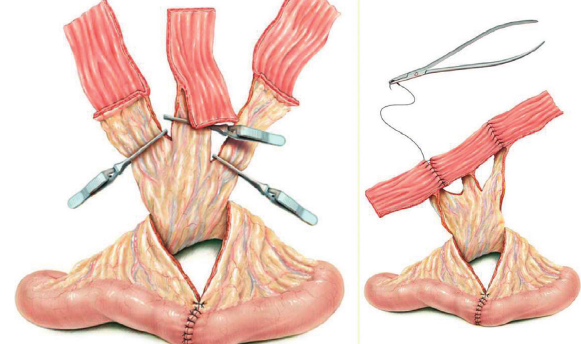
Figure 5: Yang–Monti technique (from M. A. Ghoneim and B. Ali- El-Dein, “Surgical atlas replacing the ureter by an ileal tube, using the Yang–Monti procedure. Illustrations by Stephan Spitzer,”